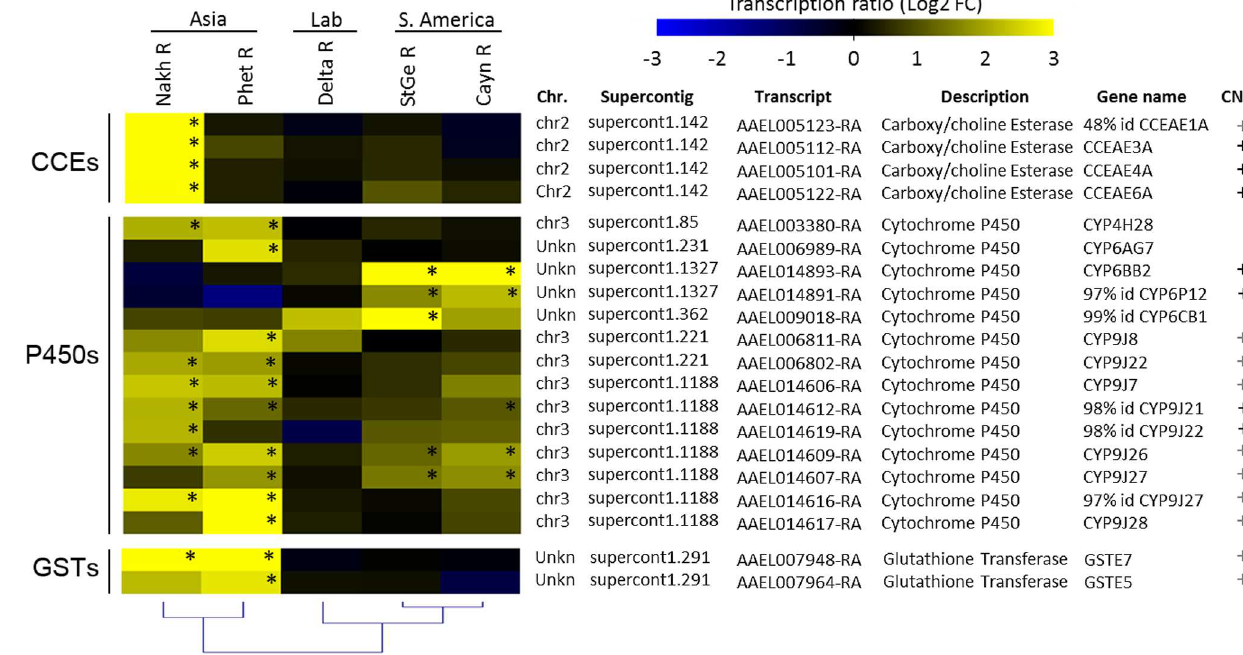
Fig 2. Transcription profiles of detoxification enzymesassociated with deltamethrin resistance. Color scale shows the mean Log 2 Fold Changebetweenresistant populationsand all susceptible strains. Stars indicate a fold change q value (cid:20) 0.001. Black ‘+’ marks indicate a significantpositivelycorrelation betweenLog 2 transcription ratios and Log 2 CNVs (Pearson’sr (cid:21) 0.7 and p (cid:20) 0.05). Grey ‘+’ marks indicate genesbelongingto genomicclusters displayingCNV associatedwith deltamethrin resistanceas reportedin [28].